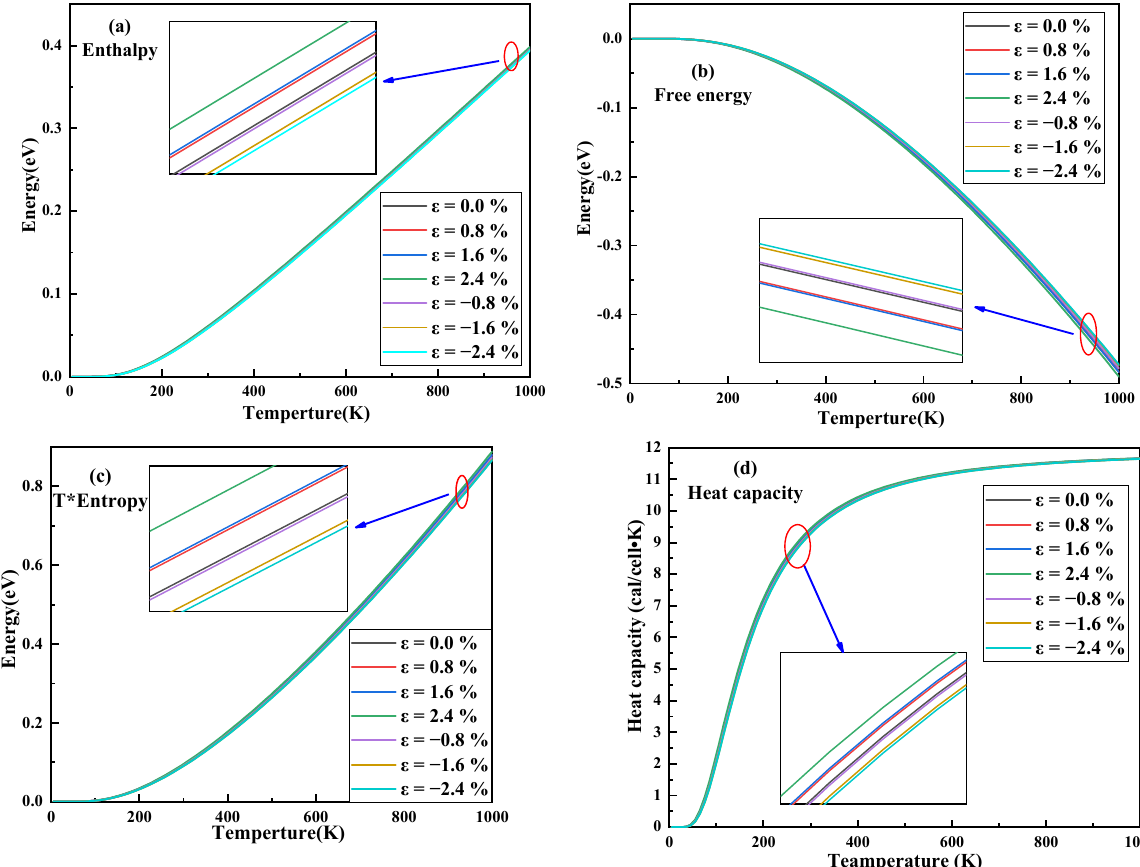
Figure 5. Enthalpy ( a ), free energy ( b ), entropy ( c ) and heat capacity ( d ) of a single layer of MoS 2 under different strains.